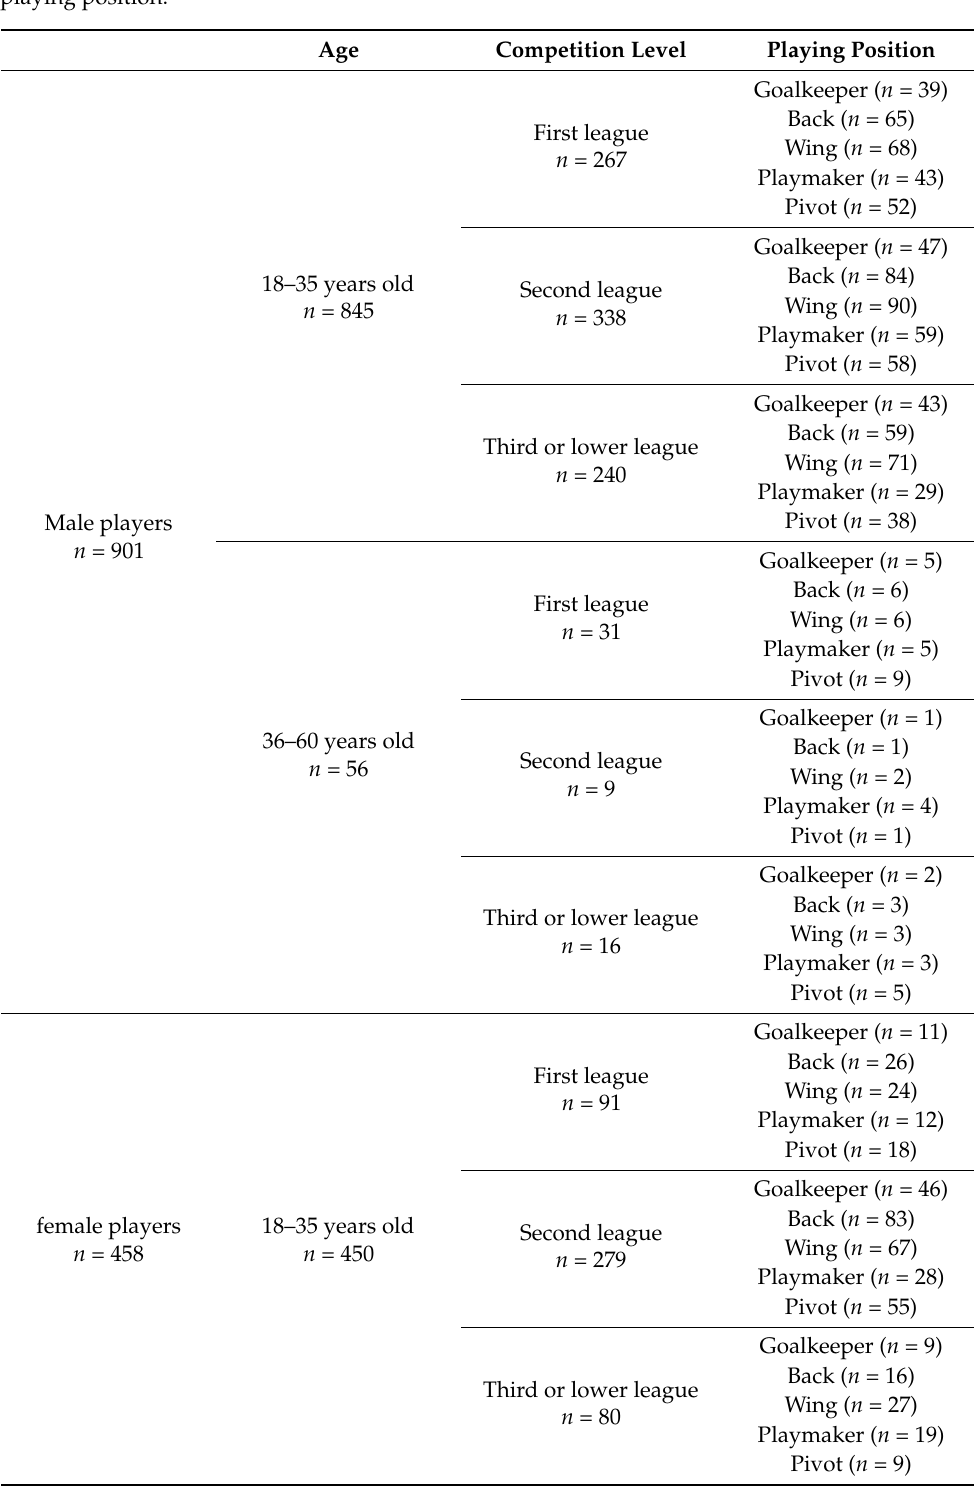
Table 3. Description of the male and female players according to age, competition level, and playing